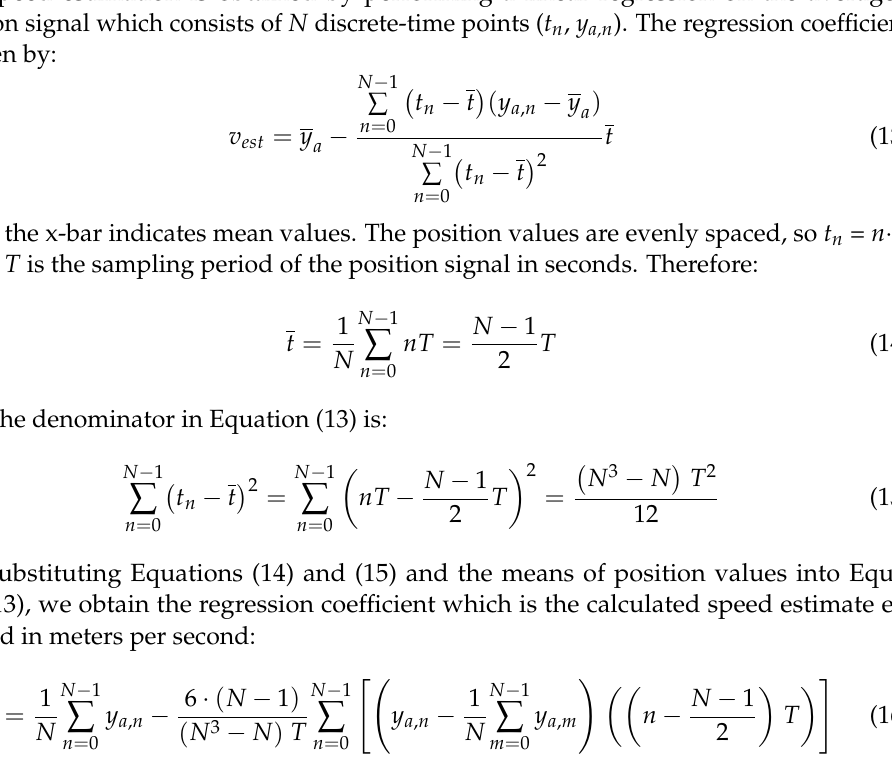
Figure 8. A block diagram of the average traffic speed estimation procedure.